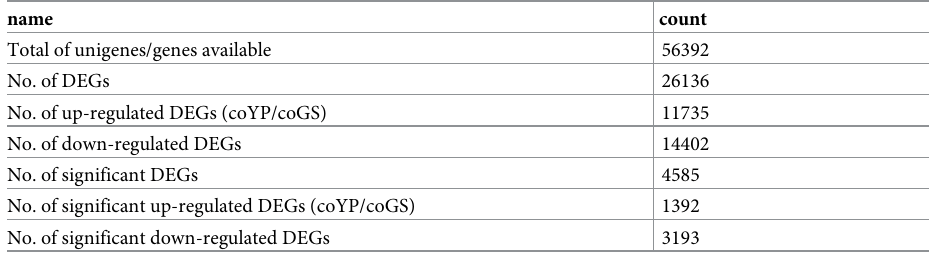
Table 2. Statistics of DEG of coYP versus